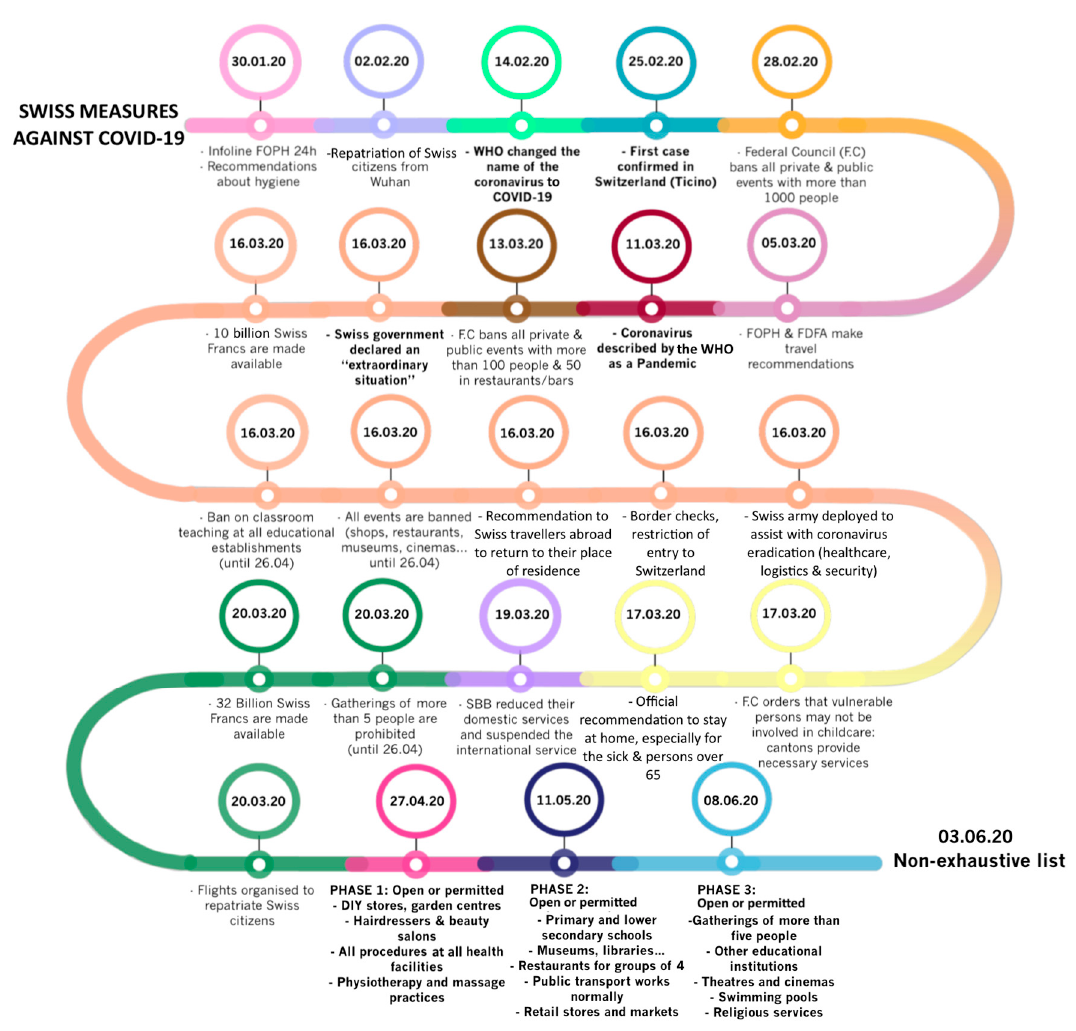
Figure 2. The timeline with the main dates and measures implemented in Switzerland to fight COVID-19. It is a non-exhaustive list updated on the 3rd of June 2020. Colors correspond to the dates.